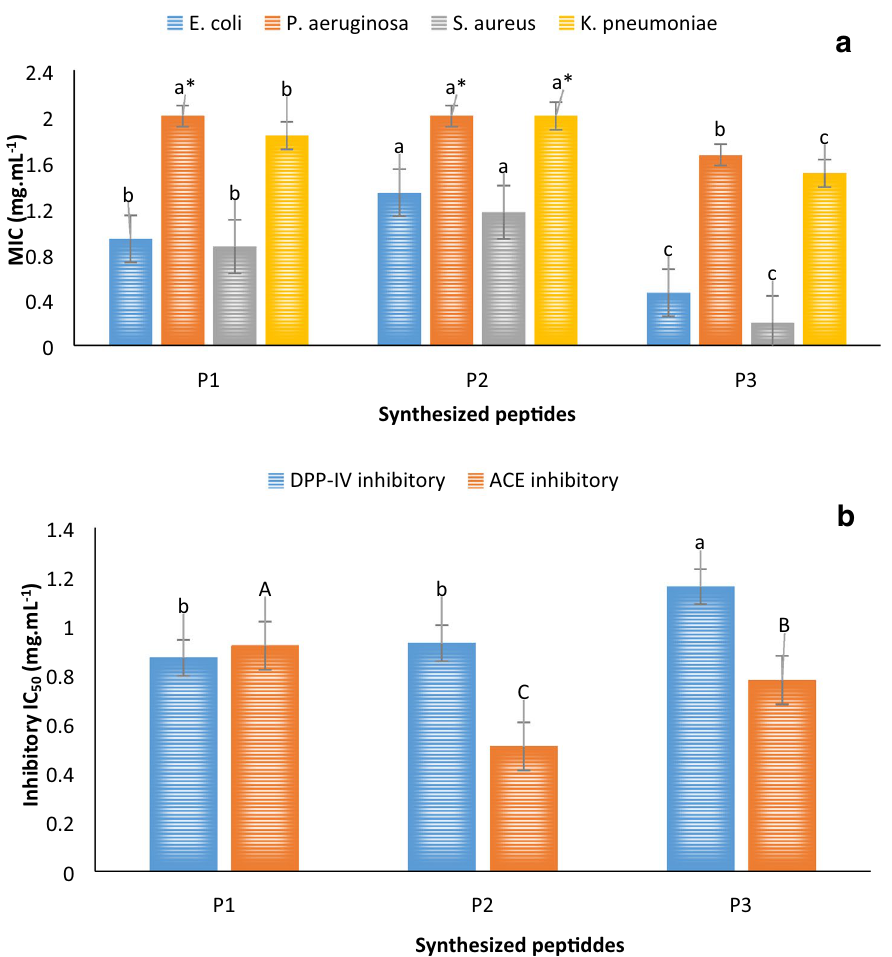
Figure 3. Biological assessment of the synthesized peptides. ( a ) Antibacterial activity, and ( b ) ACE and DPP-IV inhibition of the three peptides (P1, P2, and P3). *Indicates minimum inhibitory concentration values of ≥ 2 mg mL −1 . ACE, angiotensin-converting enzyme; DPP-IV, dipeptidyl peptidase IV; IC 50 , half maximal inhibitory